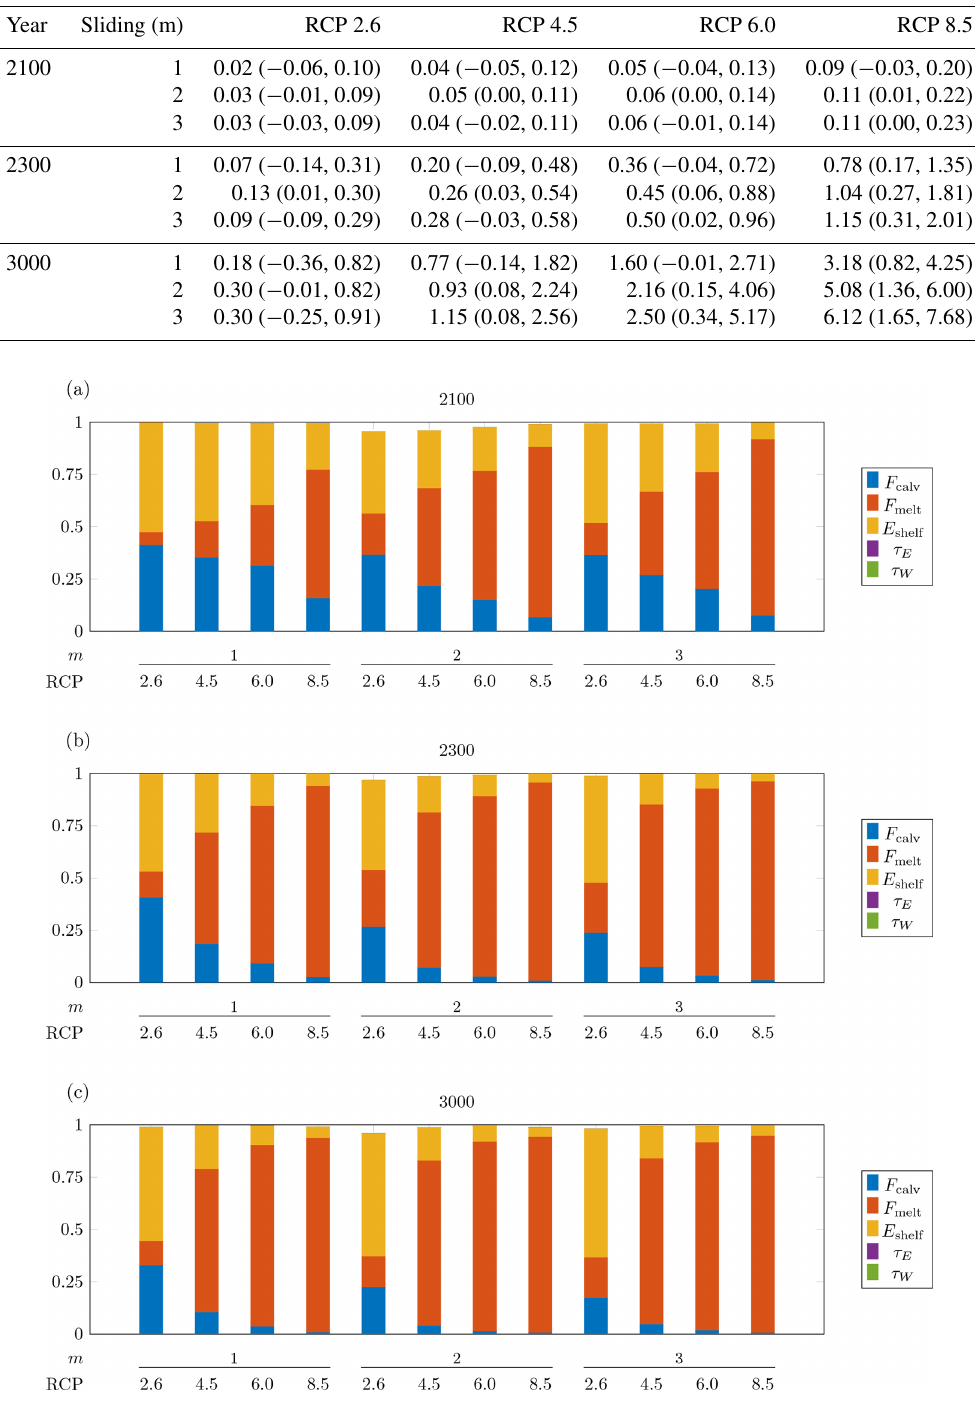
Figure 9. Sobol sensitivity indices for the AIS contribution to sea level in different RCP scenarios and for different values of the sliding exponent m in Weertman’s sliding law. Sobol indices at (a) 2100, (b) 2300 and (c) 3000. The gap between the height of a bar and the unit value represents the interaction